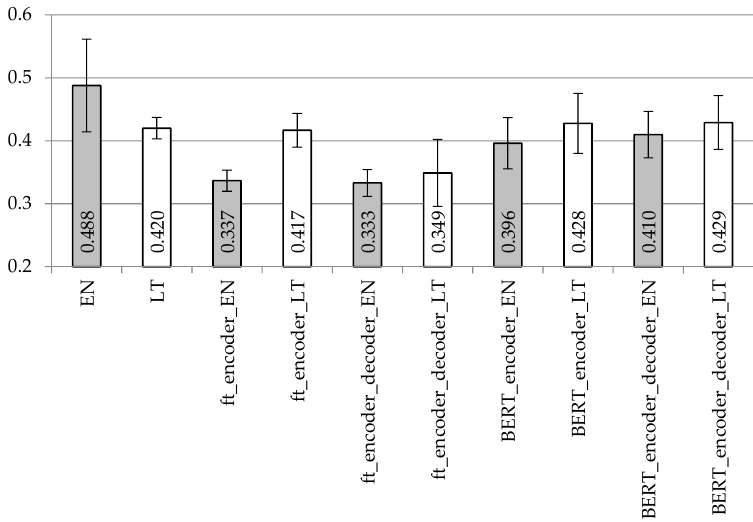
Figure 7. Averaged BLUE scores with confidence intervals using the LSTM2 encoder and LSTM decoder model with different vectorization types on the dataset with removed punctuation.